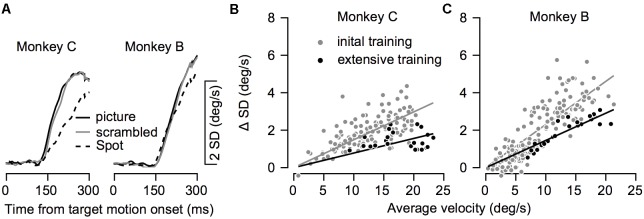
The variability in eye velocity during training. (A) The average standard deviation (SD) of the eye velocity across all recording sessions for the picture (solid black), scrambled (gray), and spot (dashed) targets. Left and right plots show data for Monkeys C and B. (B,C) The SD as a function of the mean eye velocity in all conditions before and after extensive training. Each dot shows data from a single target condition in a single direction of movement and on a single recording day. Gray and black dots show data before and after extensive training. Lines show the regression through the origin and correspond to the colors of the dots.